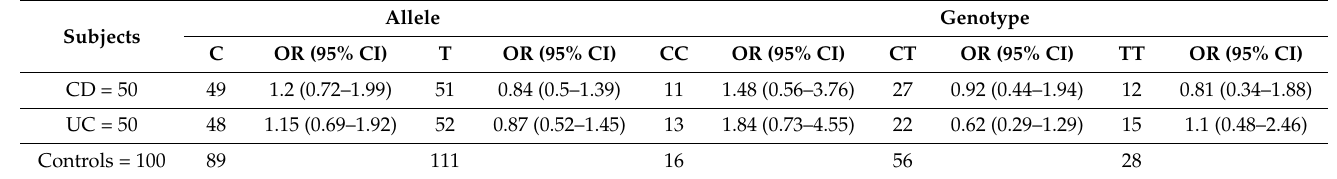
Table 3. Distribution of C3435T alleles and genotypes (cases and